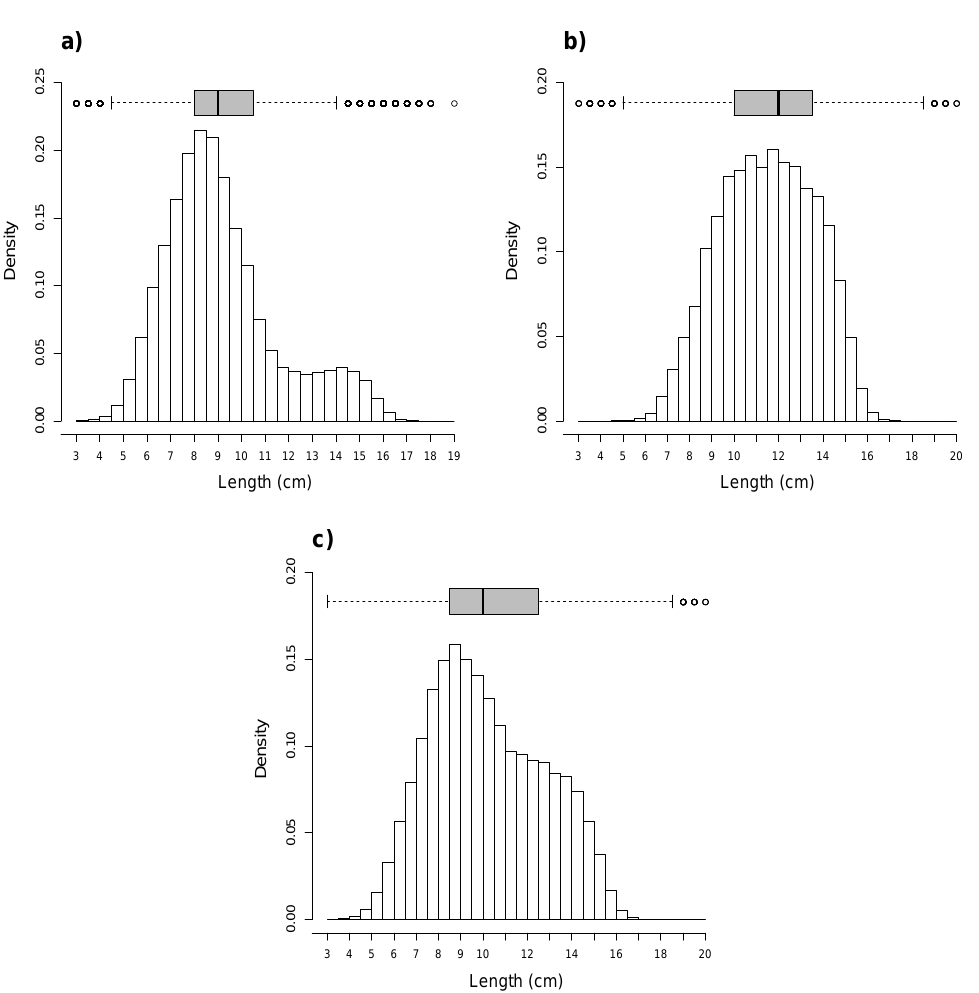
Figure 2. Boxplots and histograms of lengths of ( a ) V.–VIII., ( b ) IX.–XIV., and ( c ) V.–XIV. Regions and period